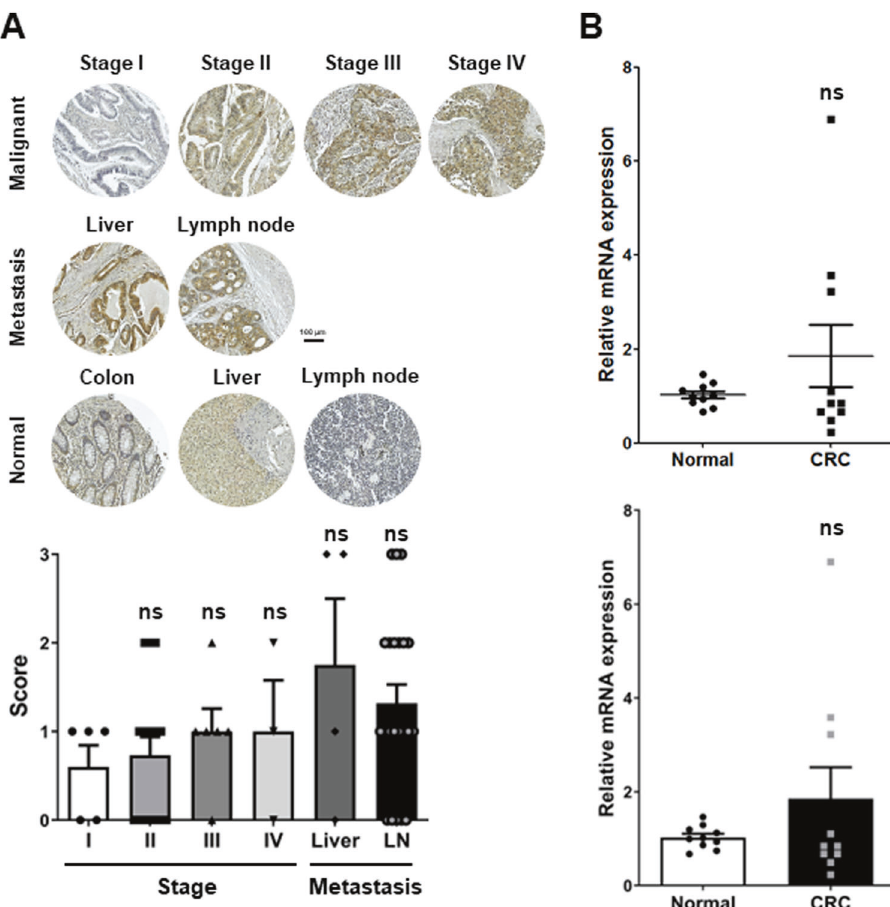
Fig. 5 Validation of the possibility of NCKAP1 as a cancer diagnostic marker. A IHC was performed with anti-NCKAP1 from TMA. Bar, 100 μ m. Quantitative results on the right: the graph represents the score of NCKAP1. Data are reported as the mean ± SEM. One-way ANOVA and Bonferroni ’ s post hoc test. ns p > 0.05 vs. Stage I. (Stage I: n = 5, II: n = 16, III: n = 6, IV:3, Liver: n = 4, LN: n = 22). B The mRNA expression of NCKAP1 was con fi rmed by qRT-PCR analysis in blood buffy coats from patients with colon cancer. The bar graph below the dot graph represents the mean. Data are reported as the mean ± SEM. Student ’ s t-test. ns: non-signi fi cant ( n =